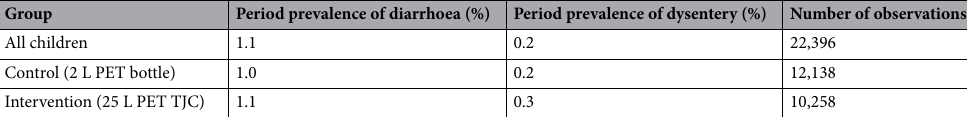
Table 1. Prevalence of diarrhoea and dysentery in the control and intervention